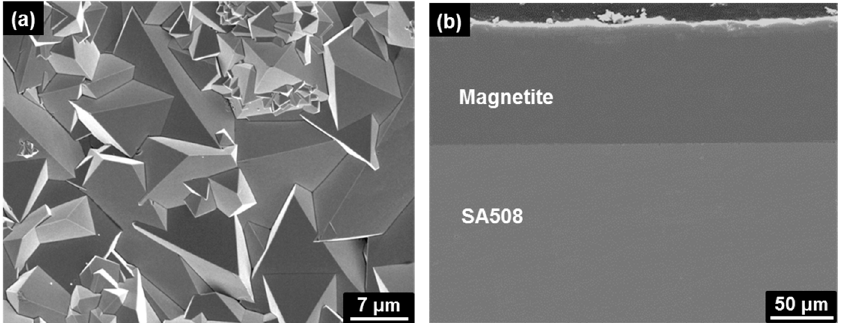
Figure 3. SEM images of the magnetite layer electrodeposited on the SA508 substrate: ( a ) surface, and ( b ) cross-section.